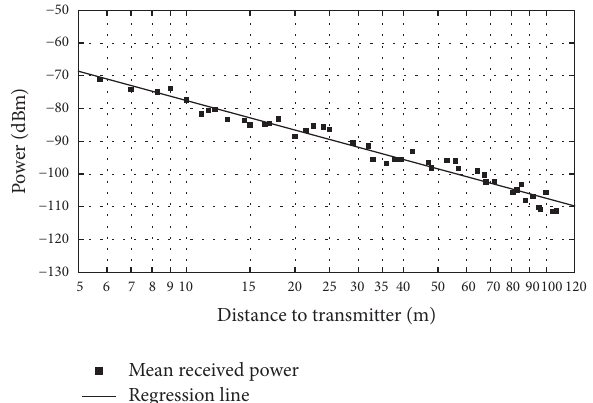
Figure 4: Pine tree, received power (dBm) versus distance in log- arithm axis, Tx back, and Rx angle LoS.